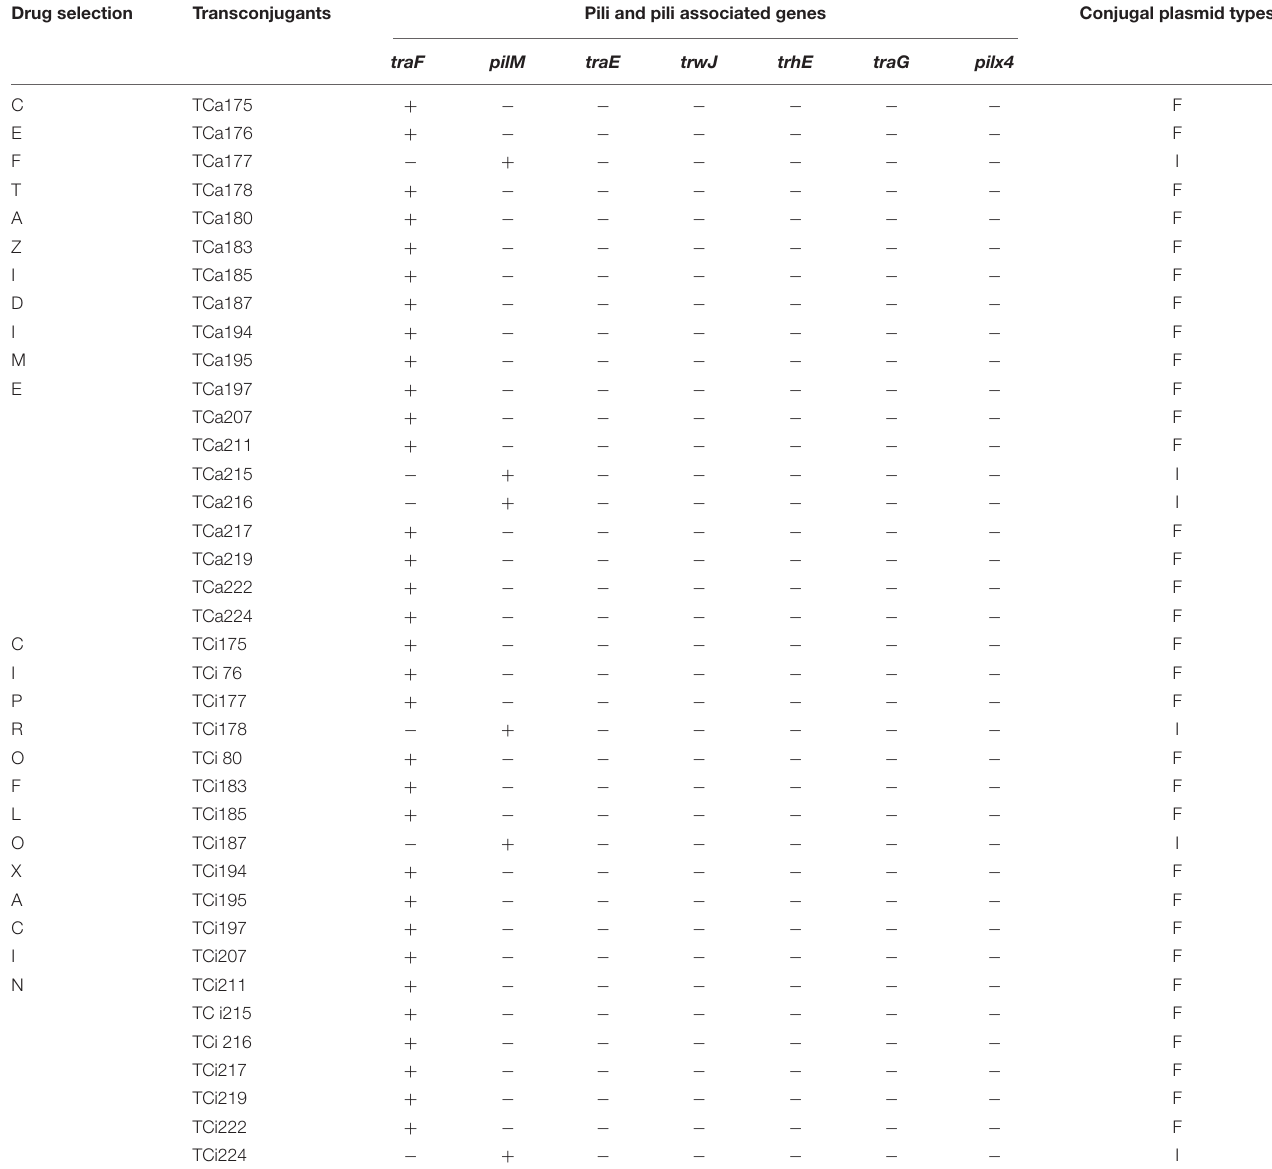
TABLE 5 | Conjugal plasmid types associated with transmissible resistant plasmids in